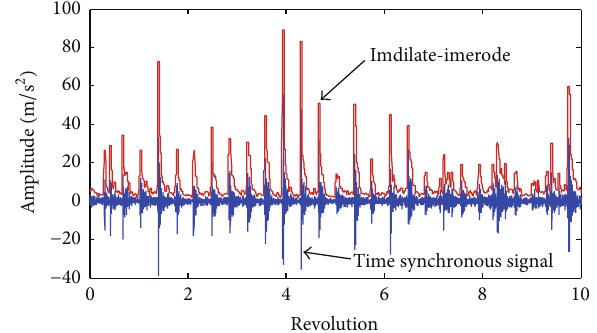
Figure 26: Result of morphological dilation-erosion gradient.